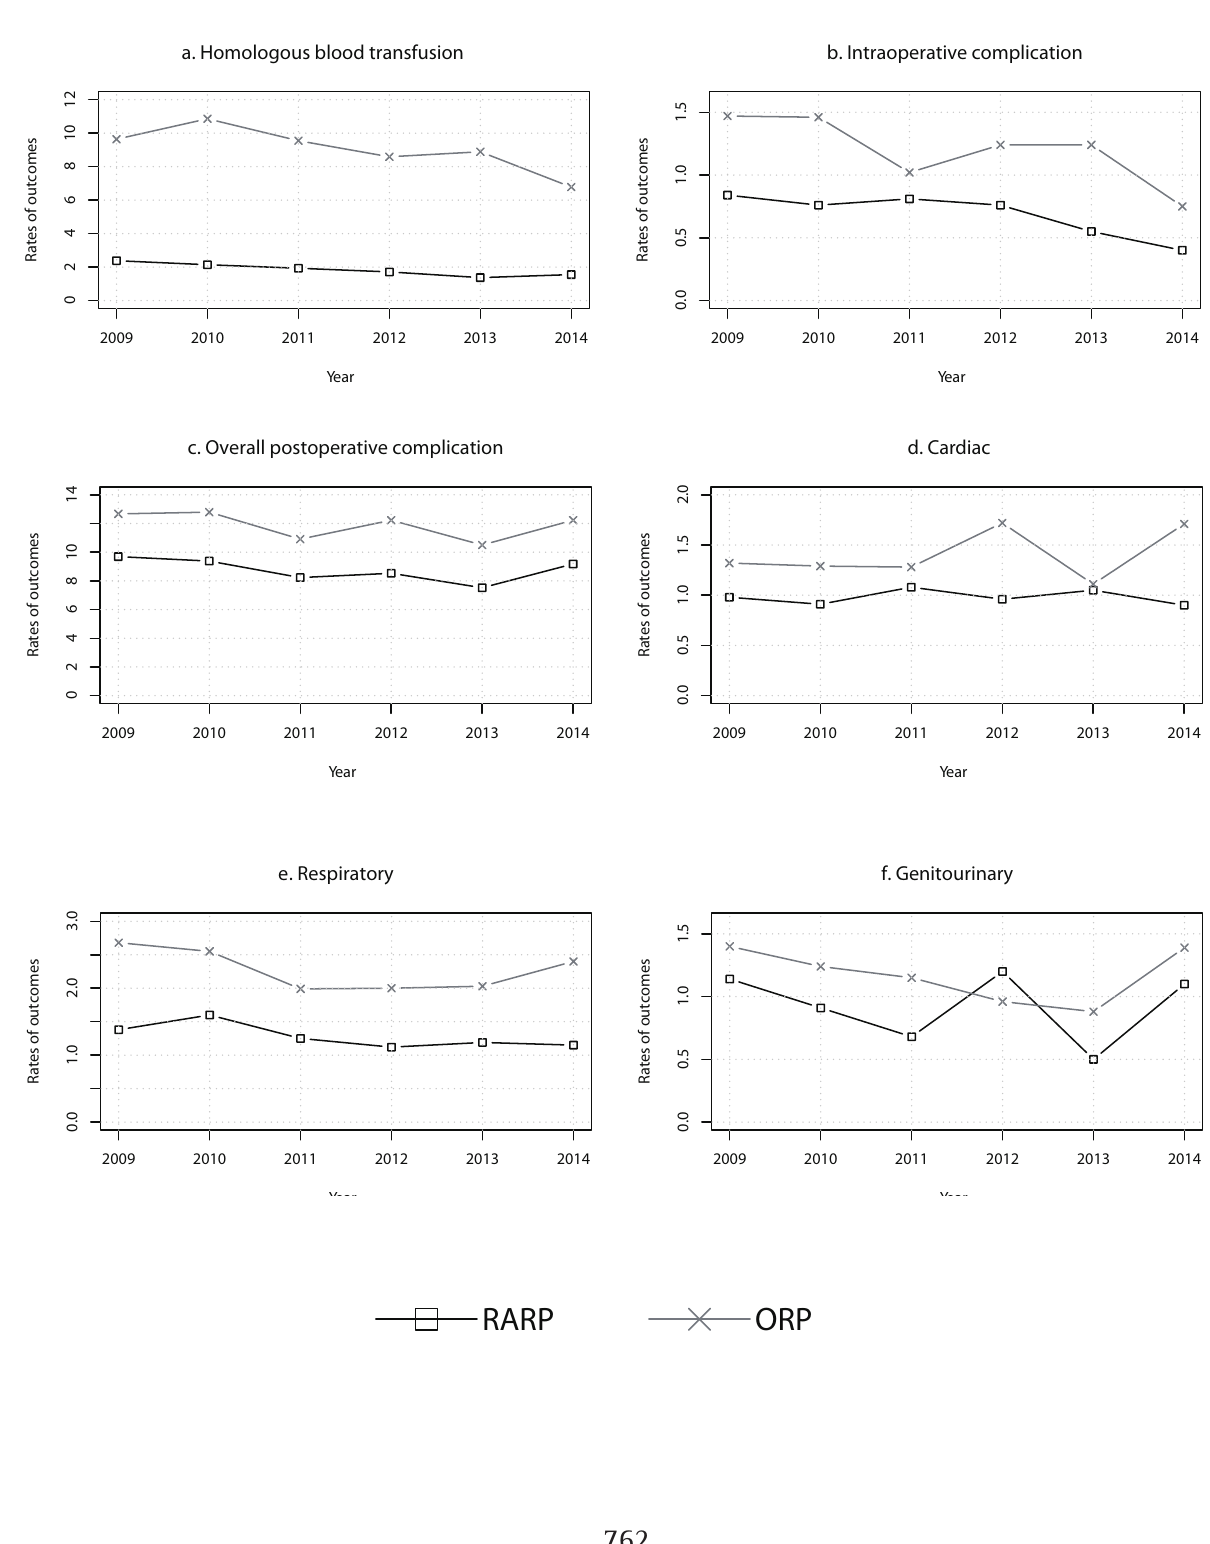
Figure 2 - The incidence rates of the perioperative outcomes for the Robot-assisted Radical Prostatectomy group and the Open Radical Prostatectomy group from 2009 to 2014 (post-propensity score-matched